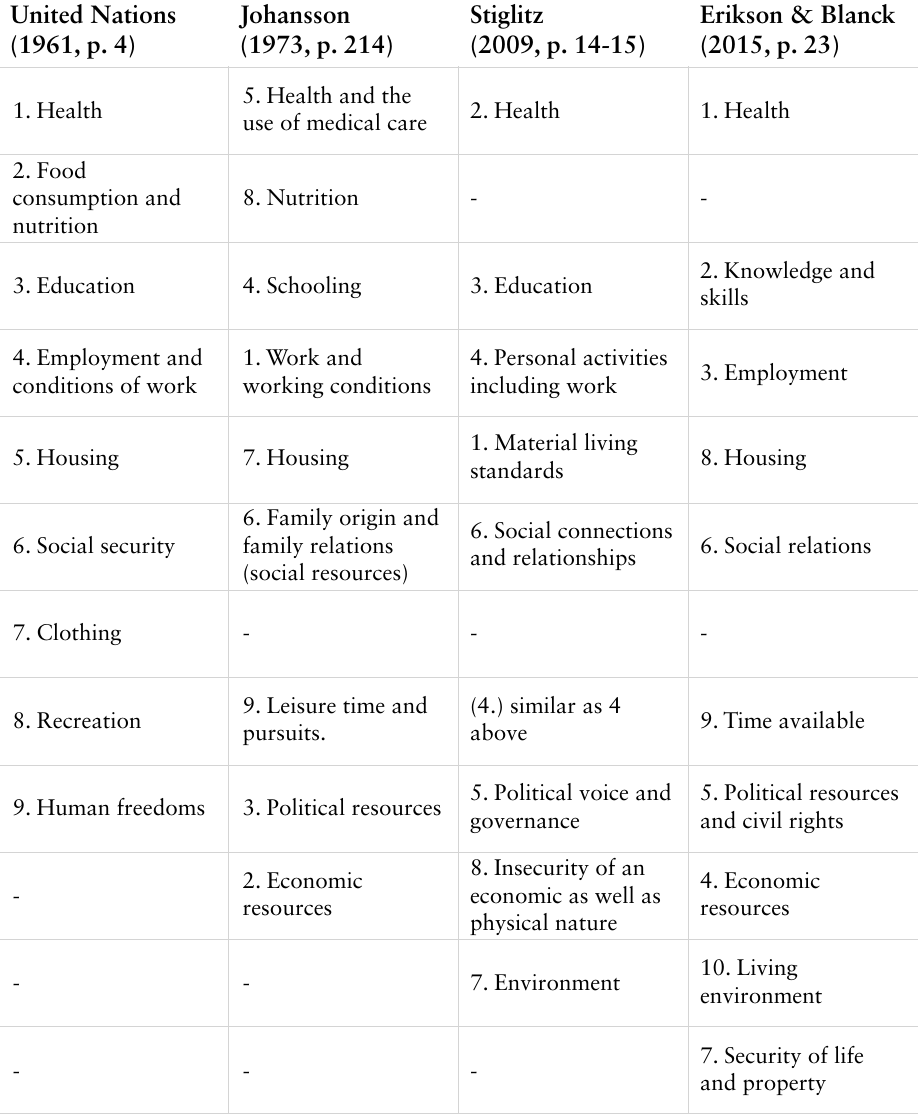
Table 1. Comparison of indicators for measuring quality of life. English in original, see Nations 1961, p. 4, Johansson 1973, p. 214, Stiglitz, Sen, and Fitoussi 2009, p. 14-15, Erikson and Blanck 2015, p. 23. The concepts have been ordered with regards to the United Nations (1961) order. Numbers are the original order in each